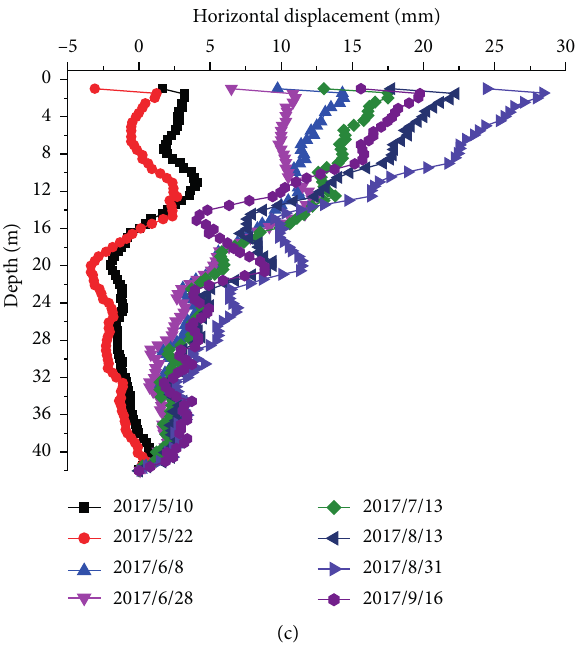
Figure 9: Horizontal displacements at monitoring holes: (a) JC01; (b) JC02; (c) JC03.